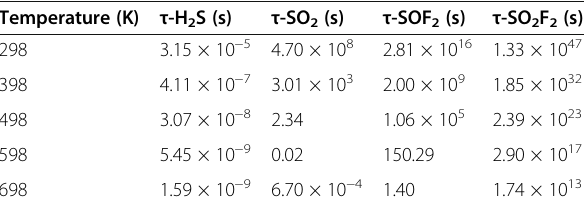
Table 2 The recovery time of ZnO-C 3 N towards H 2 , CH 4 , and C 2 H 2 at different temperature Temperature (K) τ -H 2 S